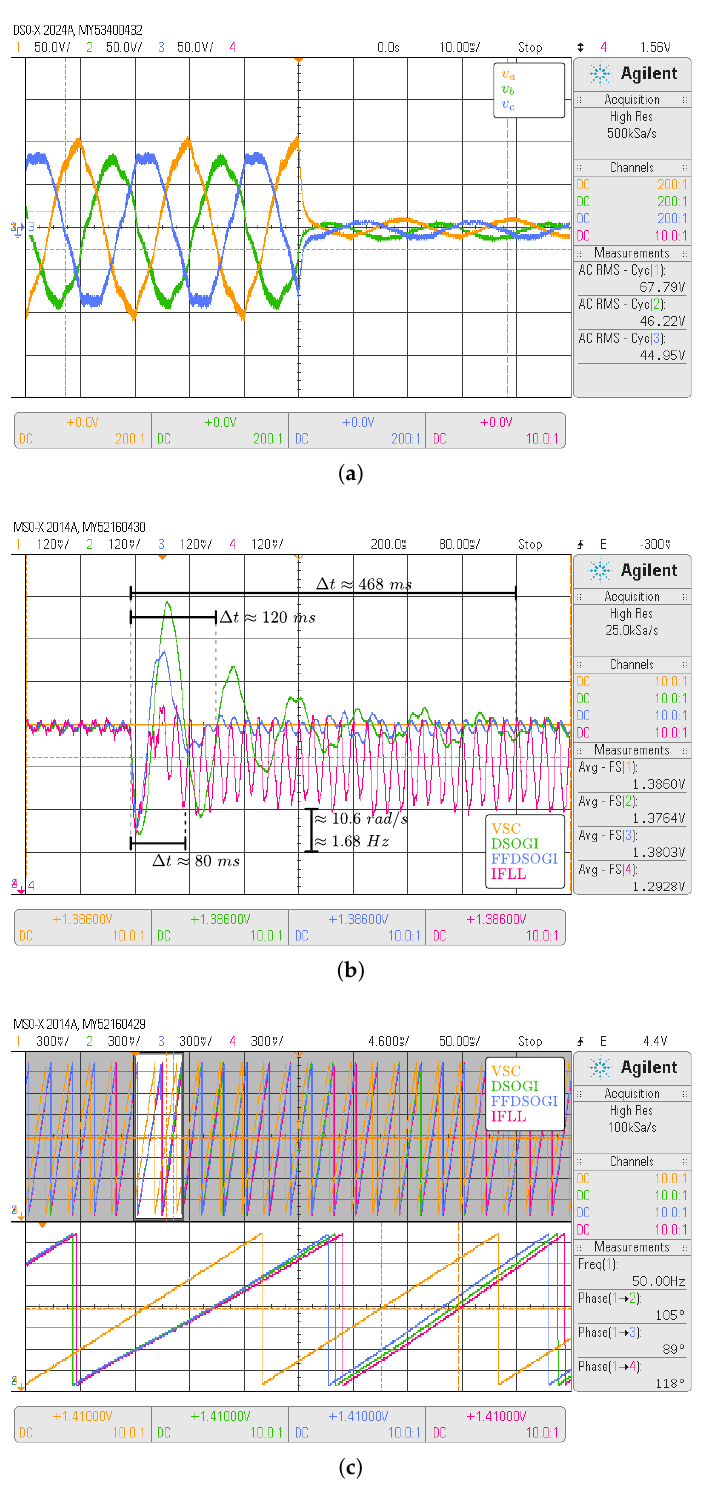
Figure 22. Experimental results for test #3. ( a ) Measured voltages, ( b ) estimated frequency and ( c ) estimated phase